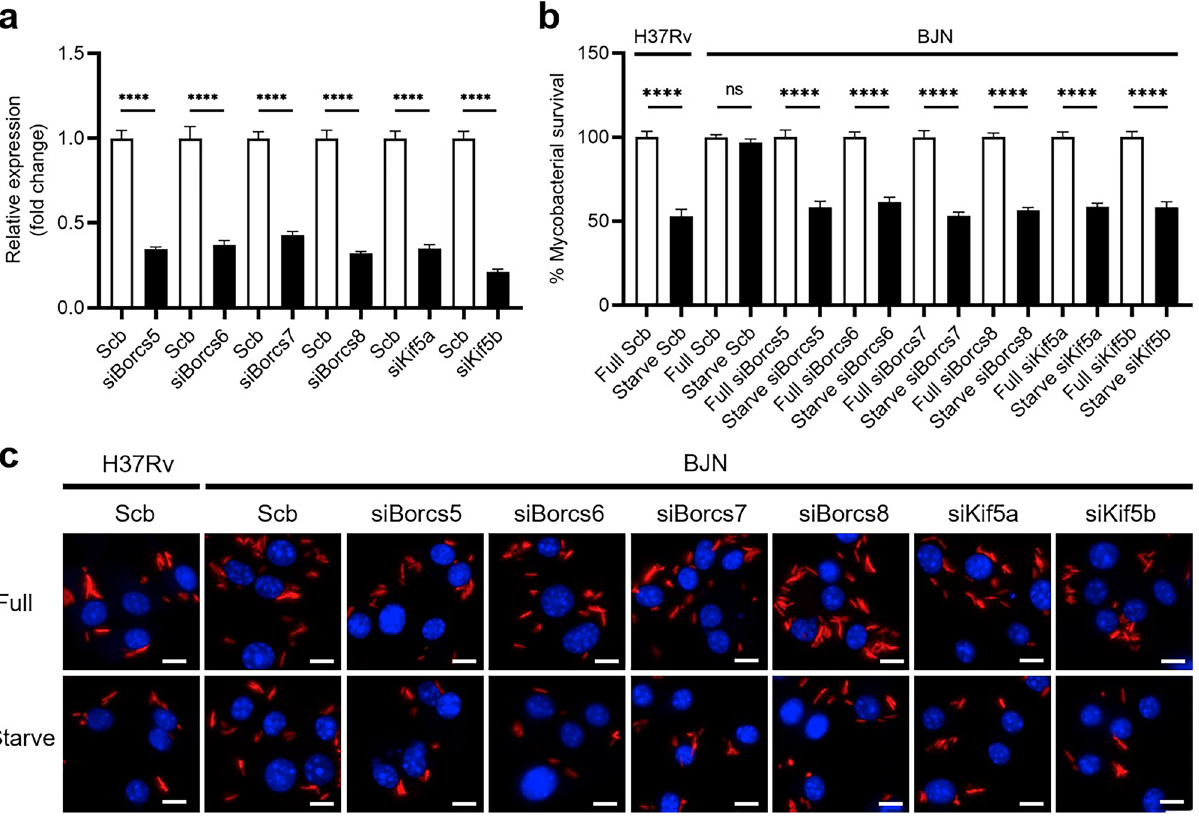
Figure 3. Depletion of BORCS5-6 and Kinesin-1 reverts the BJN’s ability to resist autophagic elimination in BMDMs. ( a ) BMDMs were transfected with siRNAs, as in Fig. 1. Successful knockdown was determined by qRT-PCR. Expression levels of the target genes were normalised to that of the housekeeping gene, Gapdh . Data are means ± SEM from at least three independent experiments; ****p < 0.0001, relative to the scrambled siRNA control set to 1.0 determined by one-way ANOVA with Tukey’s multiple comparison test. ( b,c ) BMDMs with decreased expression of BORCS5-8 and Kinesin-1 were infected with the mCherry-expressing H37Rv or BJN and induced to undergo autophagy by starvation, as in Fig. 1. High-content imaging was then used to assess the number of intracellular mycobacteria per cell. Percent mycobacterial survival was calculated and compared ( b ). Data are means ± SEM from at least three independent experiments; ns, non-significant and ****p < 0.0001, all relative to the full control set of 100% determined by one-way ANOVA with Tukey’s multiple comparison test. Representative images are displayed in ( c ). Bar 10